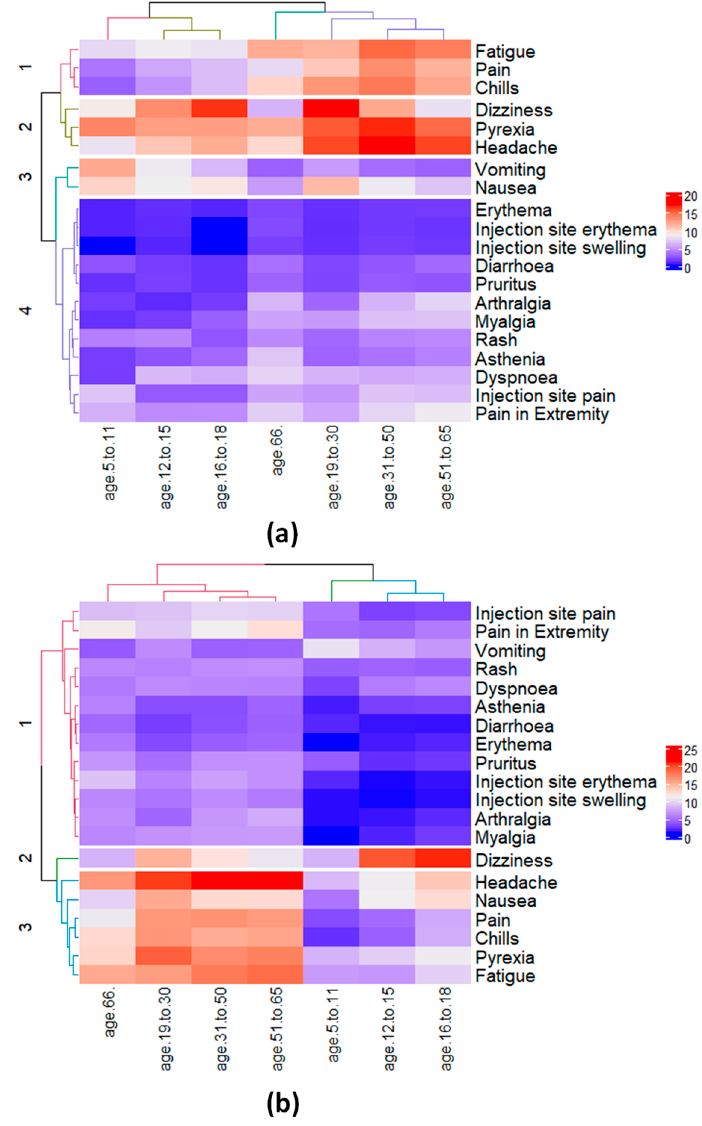
Figure 2. Hierarchical clustering of the 20 most commonly reported effects and 7 age groups for ( a ) male and ( b ) female participants. For male participants ( a ) the effects { pyrexia , vomiting , and nausea } and { dizziness , pyrexia } were reported to be the most commonly reported effects for the two children age groups 5–11 and 12–15, respectively. For female participants ( b ), the effects { headache , pyrexia , nausea , vomiting , and dizziness } were reported to be the most commonly reported effects for children age group 5–11 and 12–15, respectively, with the addition of nausea among the 3rd most-reported effect for age group